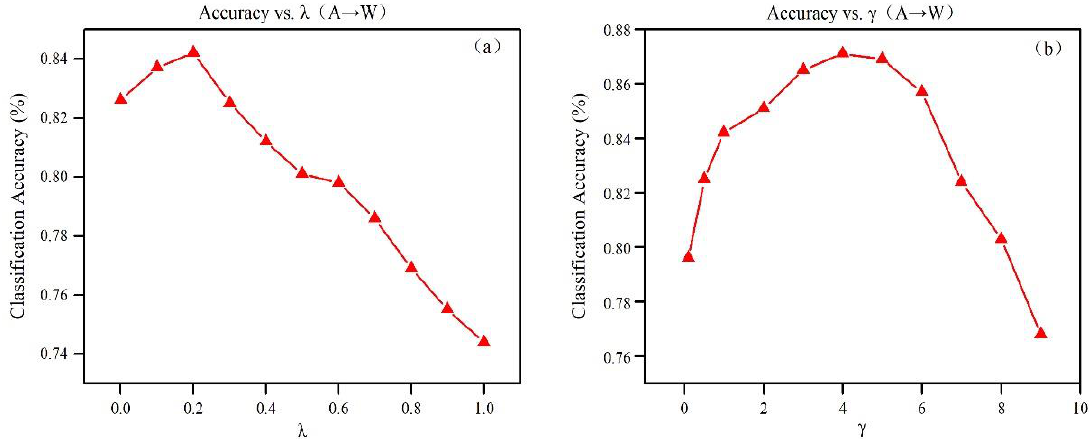
Figure 4. Sensitivity of parameters λ and γ : ( a ) accuracy vs. λ ; ( b ) accuracy vs. γ .